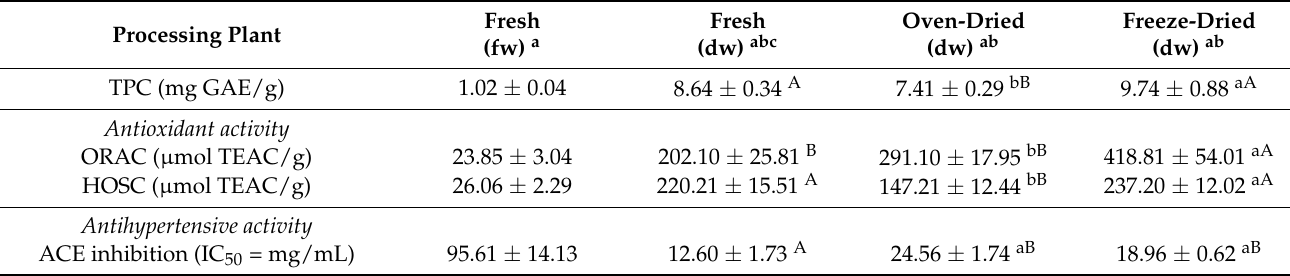
Table 5. Total phenolic content and both antioxidant and antihypertensive activities of extracts from the fresh, oven-dried, and freeze-dried S. ramosissima